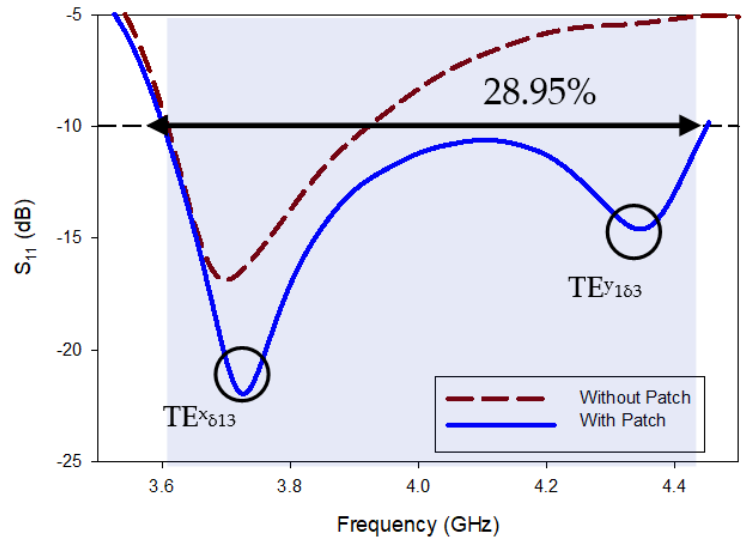
Figure 7. Analysis of simulated return loss with/without patch.